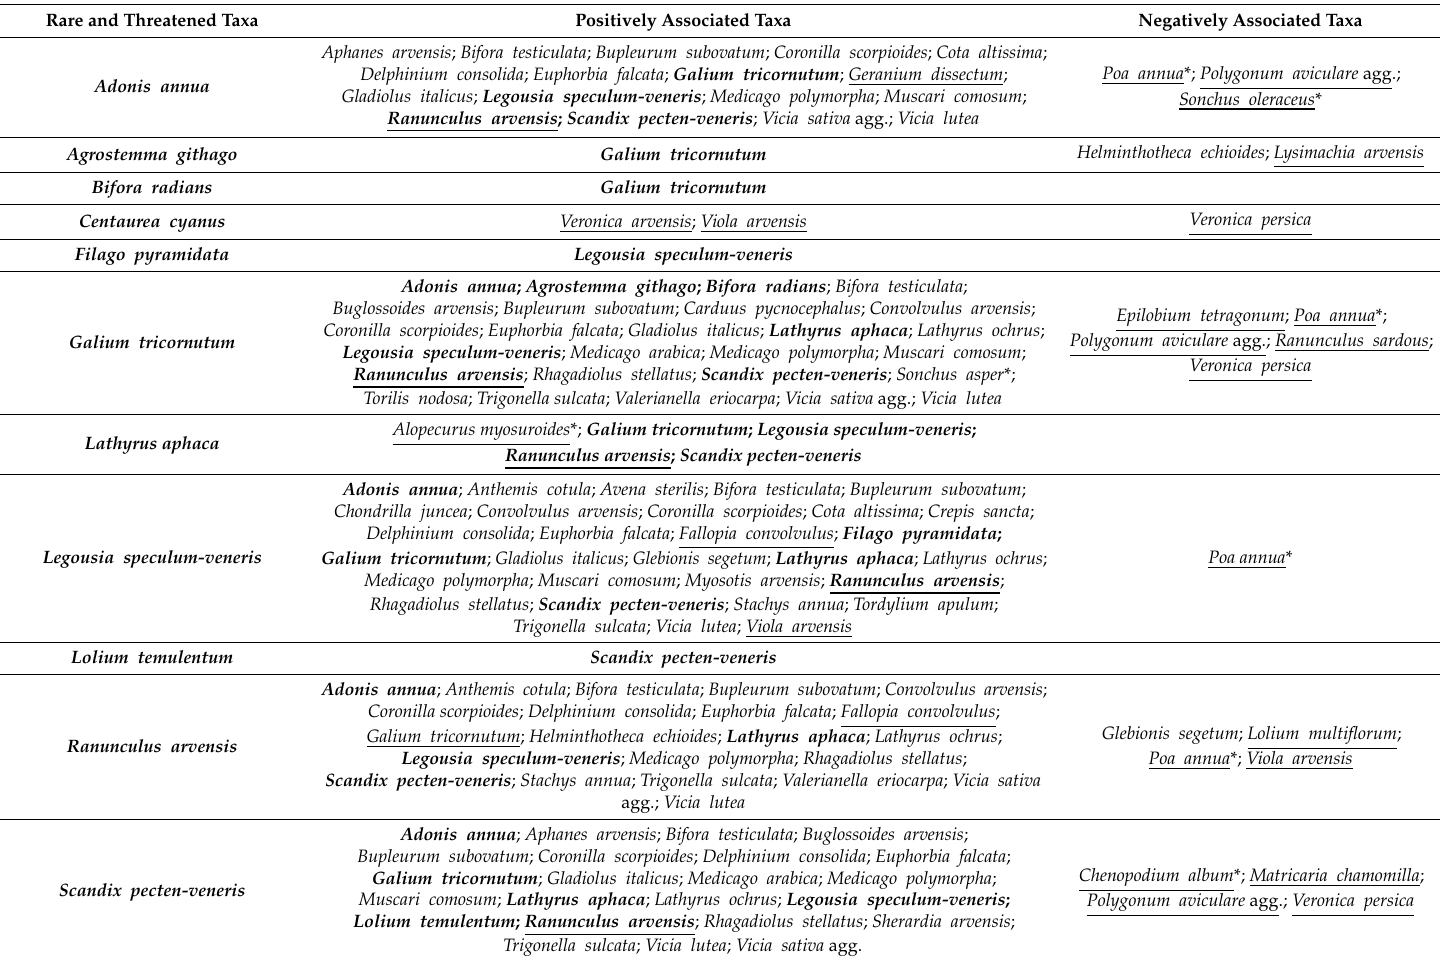
Table 1. Positive and negative associations of the rare or threatened arable species present in our dataset based on the co-occurrence analysis. Rare and threatened species [34] are highlighted in bold; the most generalist arable species [47] are underlined; nitrophilous species (Ellenberg n ≥ 7) are marked with an asterisk